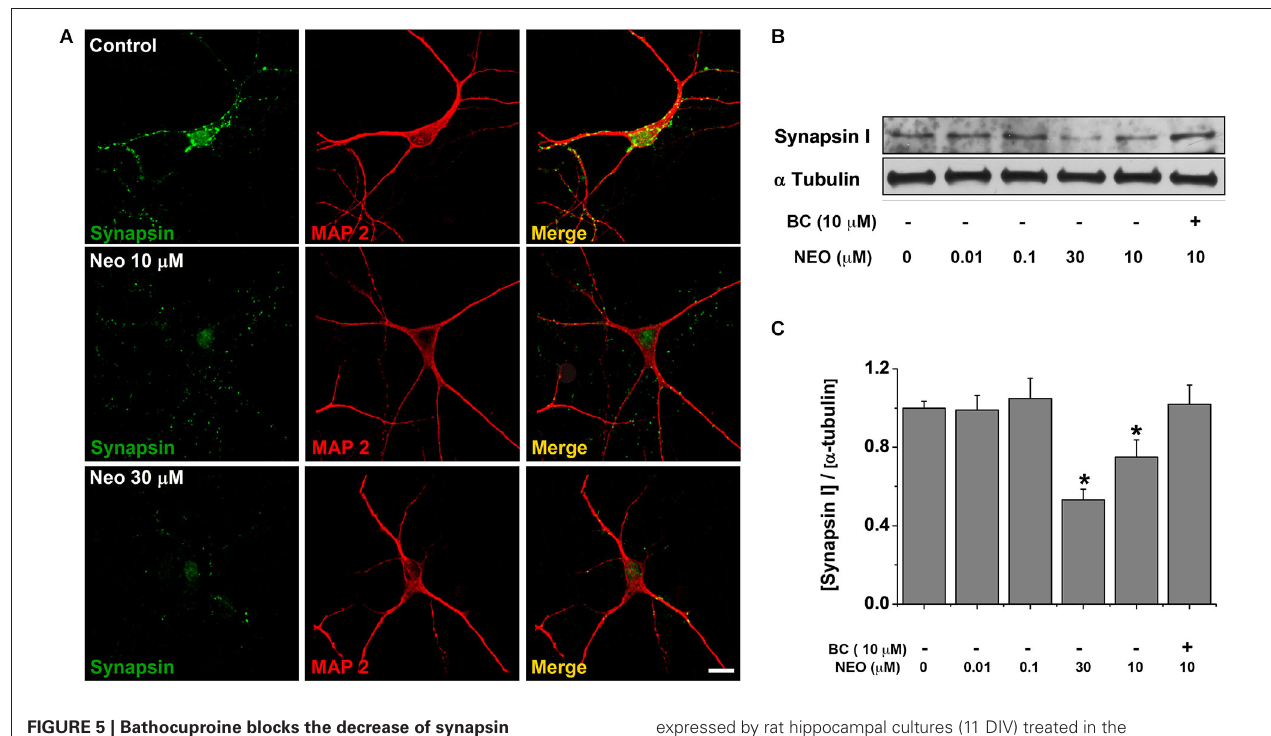
FIGURE 5 | Bathocuproine blocks the decrease of synapsin induced by Neocuproine treatments . (A) Microphotographs of rat hippocampal neurons treated with Neocuproine (Neo, 10 µ M and 30 µ M) for 12 h. Synapsin immunoreactivity is shown in green, and MAP2 in red. Scale bar, 25 µ m. (B) Protein levels of synapsin